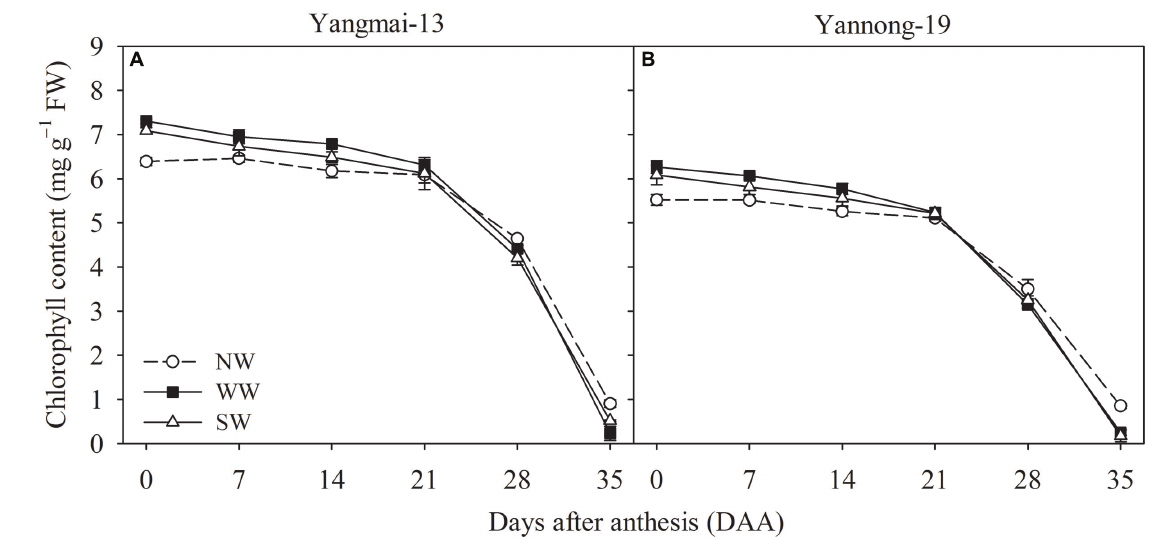
Frontiers in Plant Science |